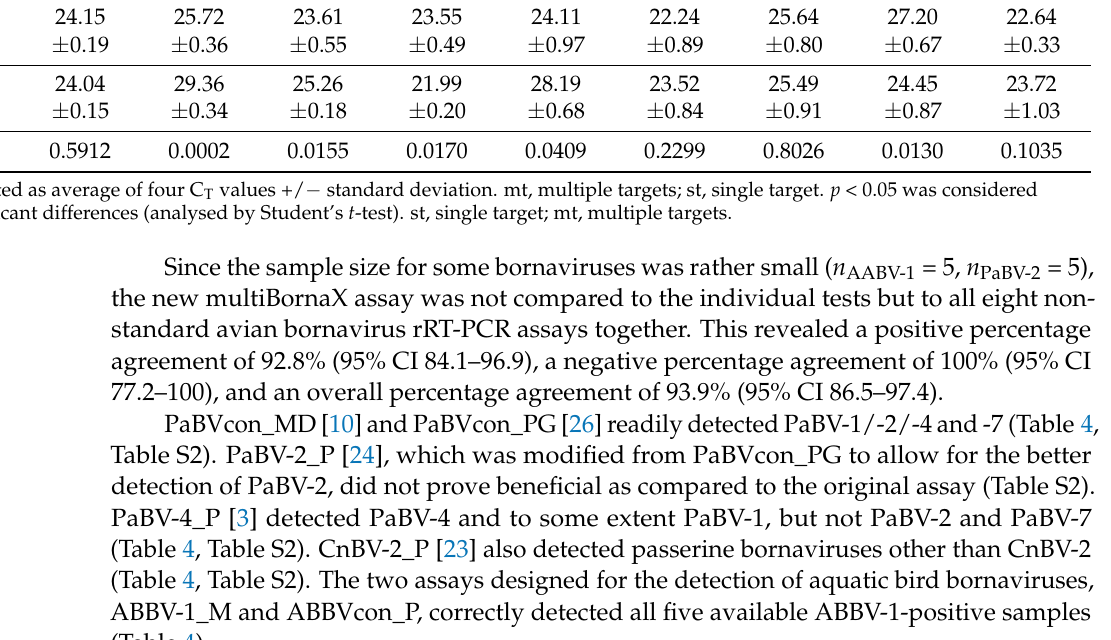
(Table 4, Table S2). CnBV-2_P [23] also detected passerine bornaviruses other than CnBV-2 (Table 4, Table S2). The two assays designed for the detection of aquatic bird bornaviruses,